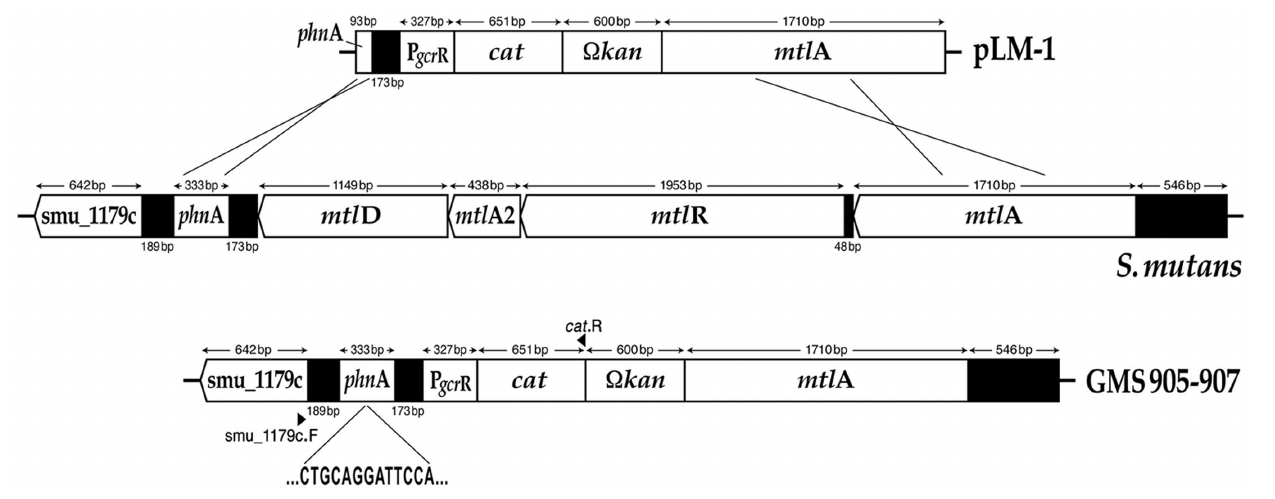
Fig. 5. Construction of the S. mutans fusion strains GMS905, GMS906, and GMS907. The integration of the P gcrR:cat fusion that is resident on plasmid pLM1 occurred via a double cross-over event into the chromosome of S. mutans UA159, GMS584 and SmuvicK at the phnA and mtlA loci. Sequencing across the S. mutans chromosome-pLM1 junction confirmed appropriate insertion of the P gcrR:cat